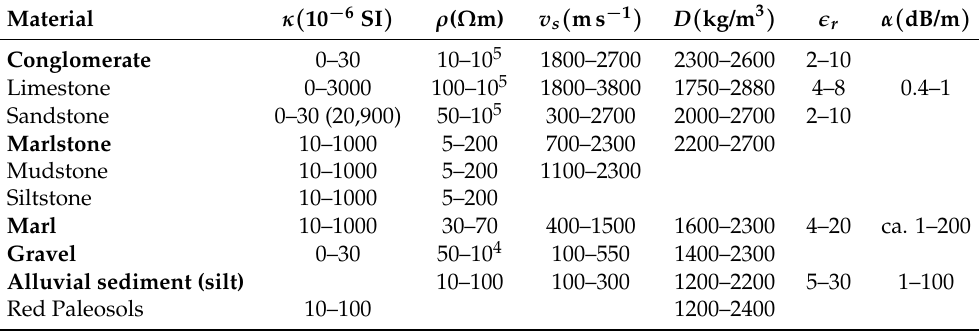
Table 1. Physical material properties according to literature of present rocks and sediments in the area of the Northern Peloponnese ([35–37]). κ , magnetic susceptibility; ρ , specific electrical resistivity; v s , seismic shear-wave velocity; D, density; (cid:101) r , relative permittivity; α , attenuation of electromagnetic waves. Bold facetype; Materials that were encountered at the archaeological sites of Aigeira and Sikyon. κ ( 10 − 6 SI